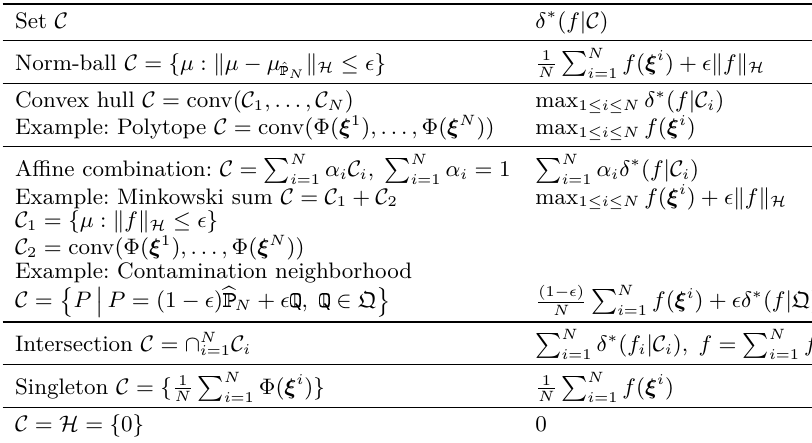
Table 5 Examples of convex sets C and their support functions δ ∗ ( f |C ) Set C δ ∗ ( f |C